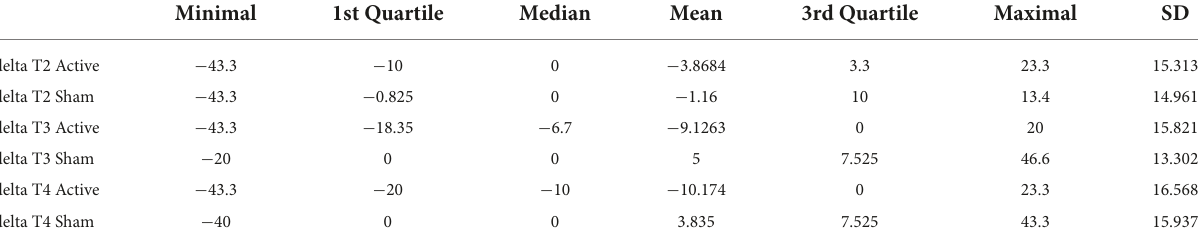
TABLE 5 Changes in the TFI Auditory subdomain and their comparison to T1 (baseline) evaluation.